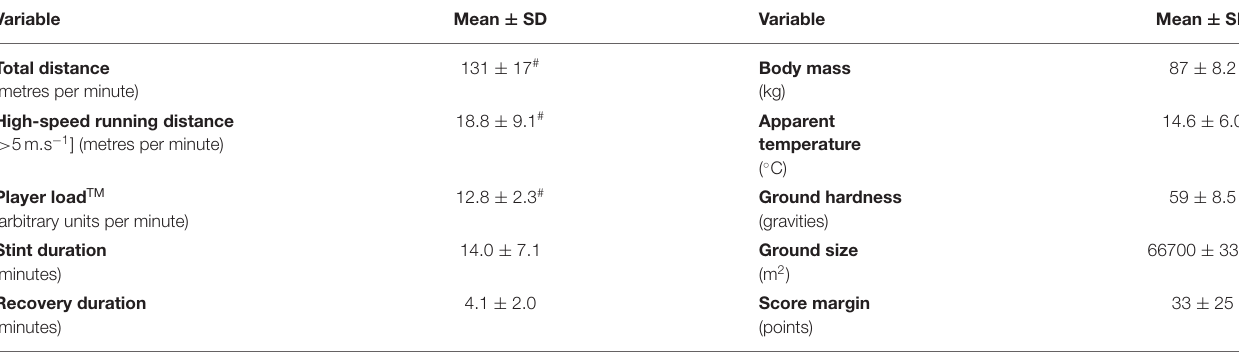
TABLE 1 | Descriptive statistics of the continuous variables.